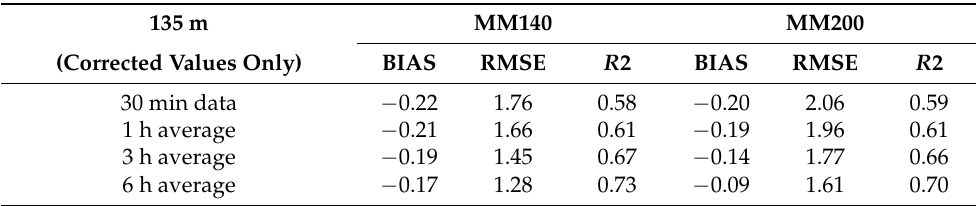
Table 5. Statistical analysis of downscaling based on temporal resolution (exemplary stratified BILIN setup). 135